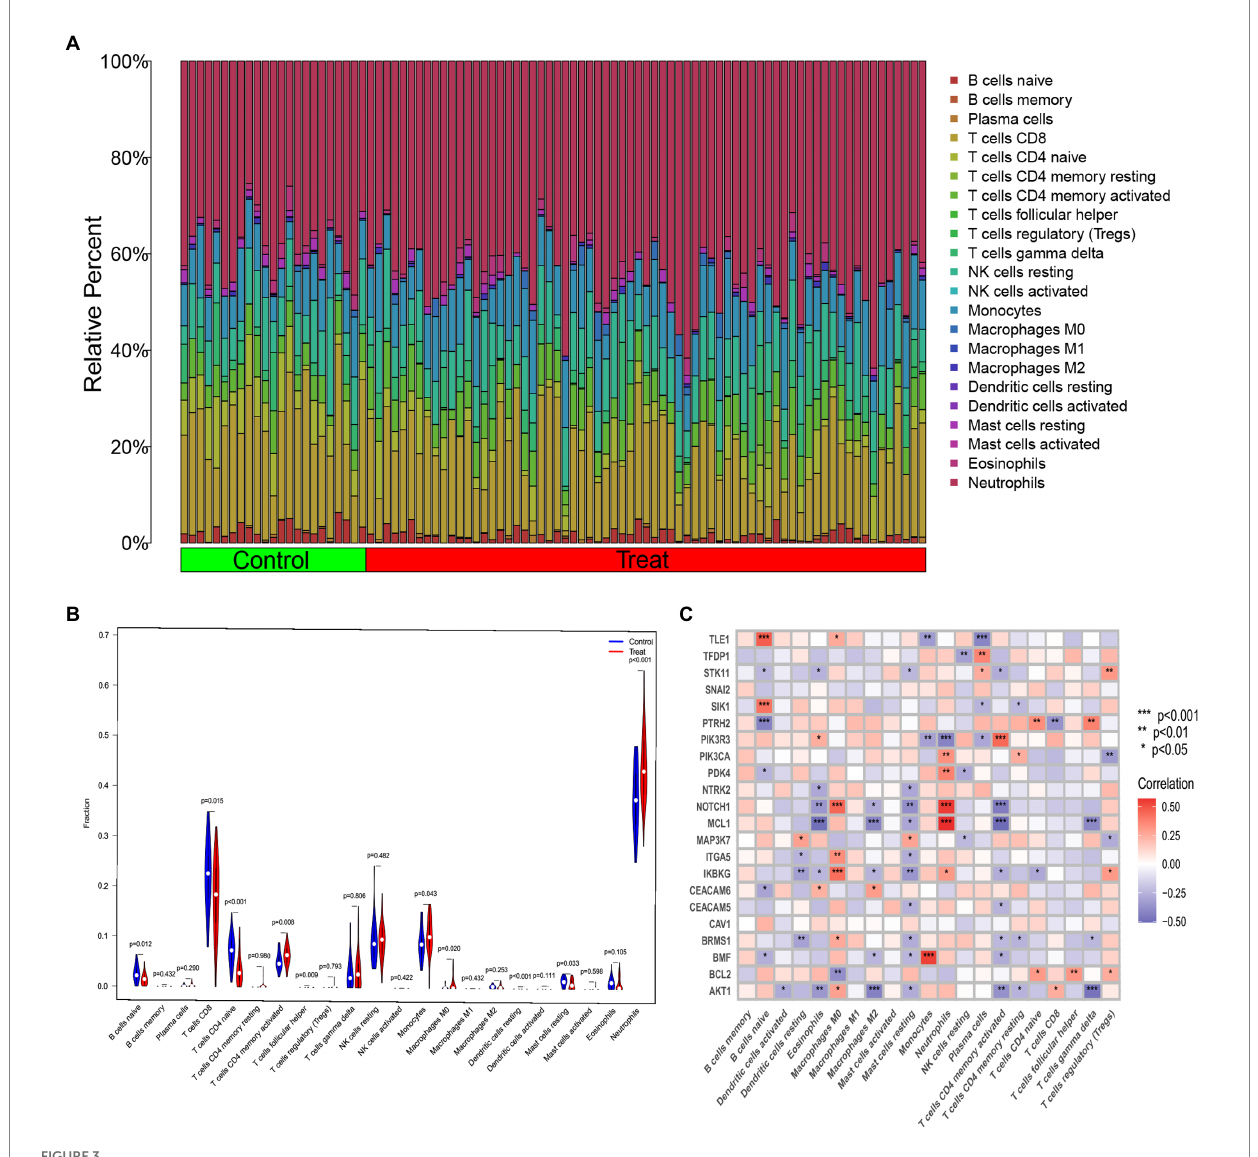
FIGURE 3 Overview of immune infiltration in IS. (A) Relative abundance of 22 infiltrating immune cells between IS and non-IS samples. (B) Violin plot showing the difference in immune infiltration between IS and non-IS samples. (C) Correlation analysis of 22 differentially expressed ARGs with infiltrating